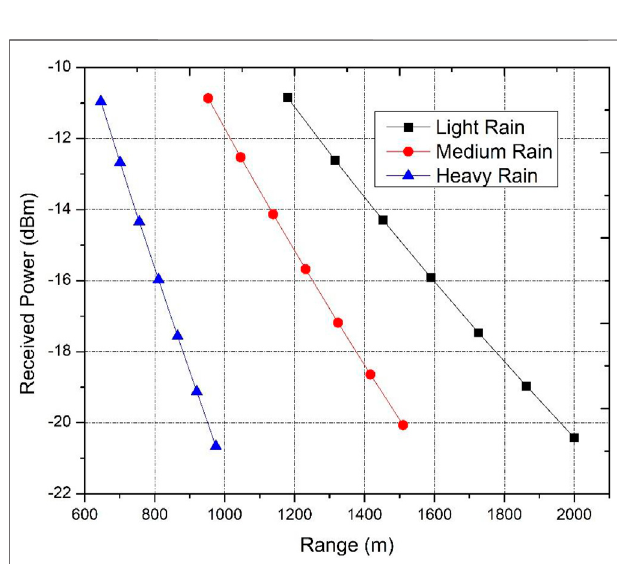
FIGURE 5 | Received power vs. range under different rain intensities for OFDM/SAC-OCDMA-FSO.